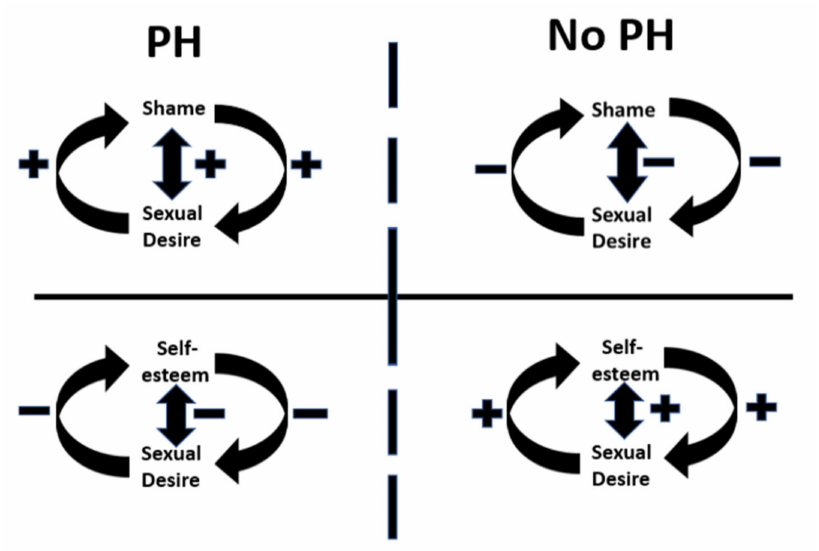
Figure 1. Overview of the contemporaneous and temporal (lagged) models used to investigate the associations of shame, self-esteem and sexual desire in men with PH and groups without PH. Note that one-headed arrows represent temporal (lagged) associations with the base of the arrow beginning at the preceding measurement and the head of the arrow ending at the current measurement. Double- headed arrows represent contemporaneous associations. The + and − represent the positive or negative value of the expected association. Note that the vertical dashed line represents the split between PH and No PH, investigated in one analysis. The horizontal continuous line indicates different models have been used to investigate shame (upper part) and self-esteem (lower